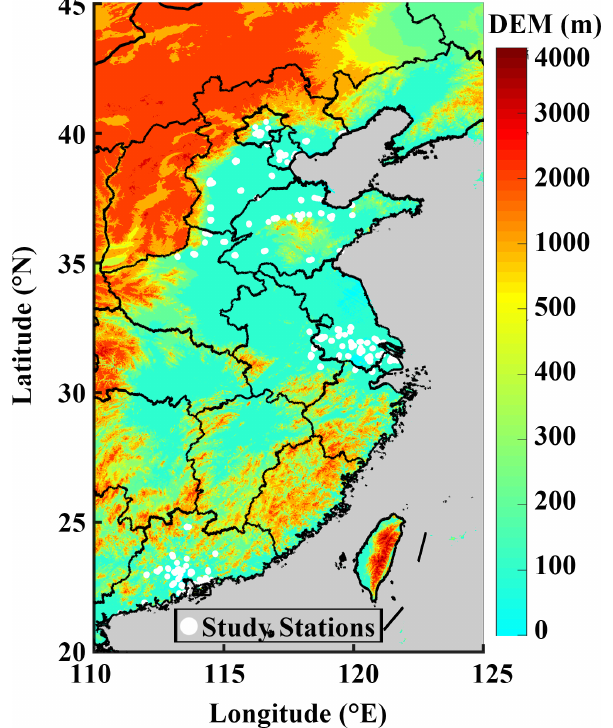
Figure 1. The study region with surface altitude (m) information from digital elevation model (DEM). The white dots are the PM 2 . 5 site stations used in this study, and the colour map represents the DEM